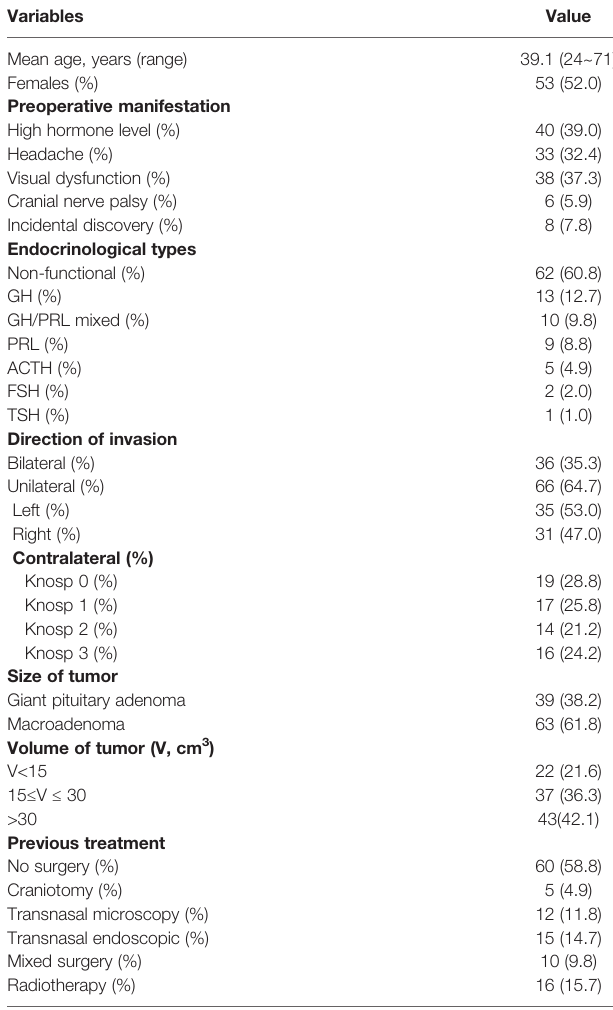
TABLE 1 | Demographic and clinical characteristics of the 102 patients with pituitary adenomas invading the CS.